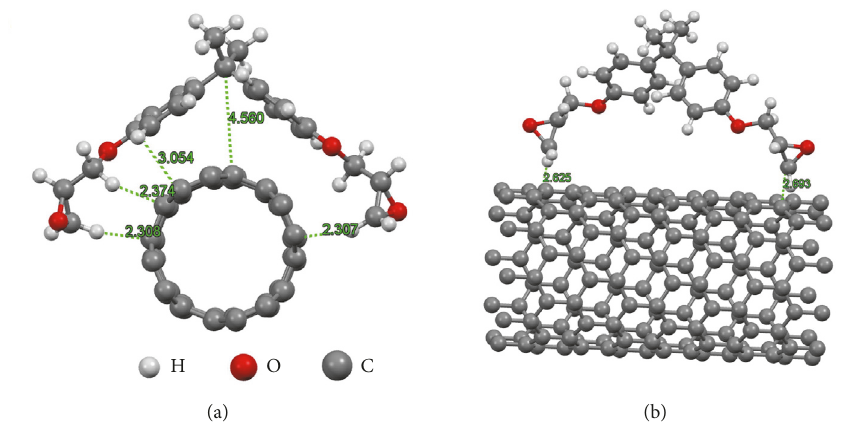
Figure 2: Epoxy monomer approached the sidewall of the carbon nanotube.